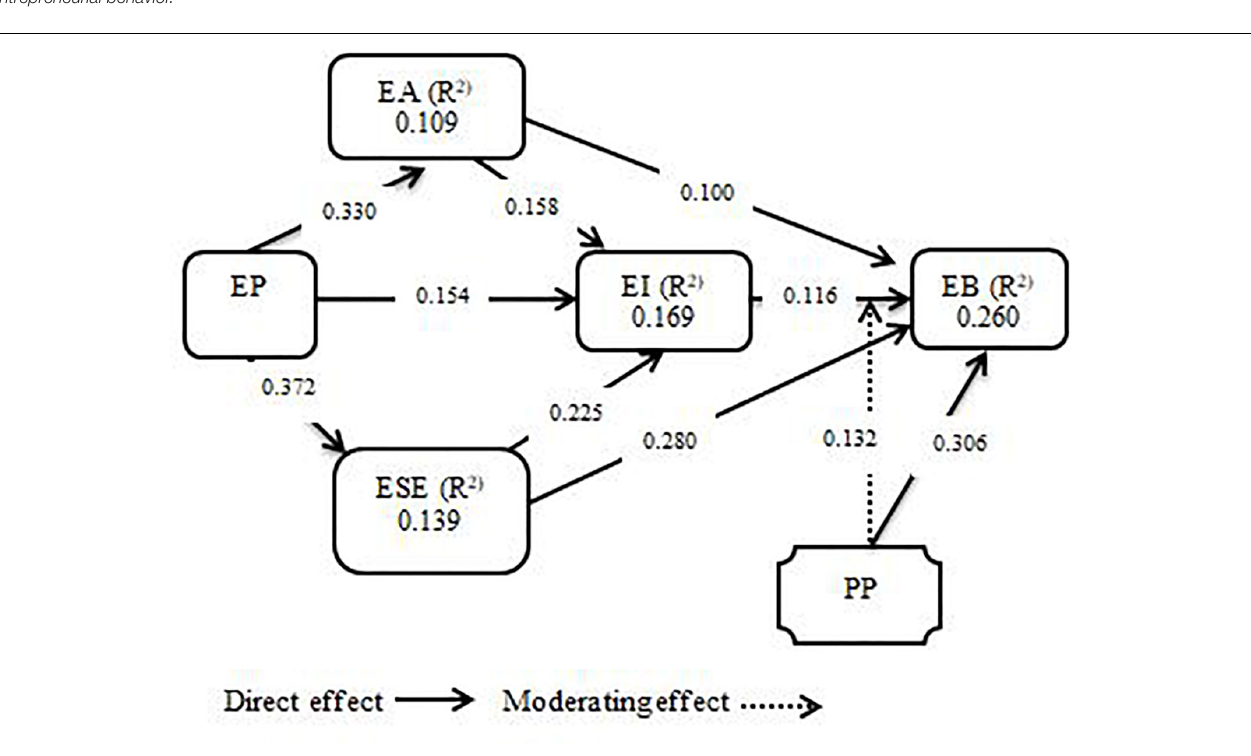
FIGURE 2 | Structural